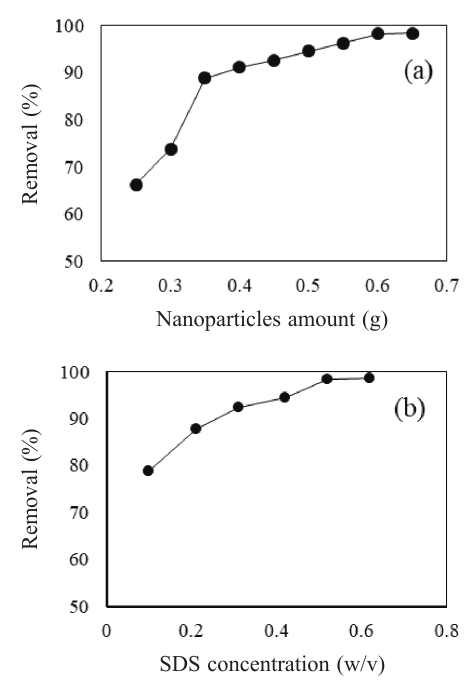
Fig. 6 – Effect of temperature on removal efficiency of TC onto Fe O -SDS. 3 4